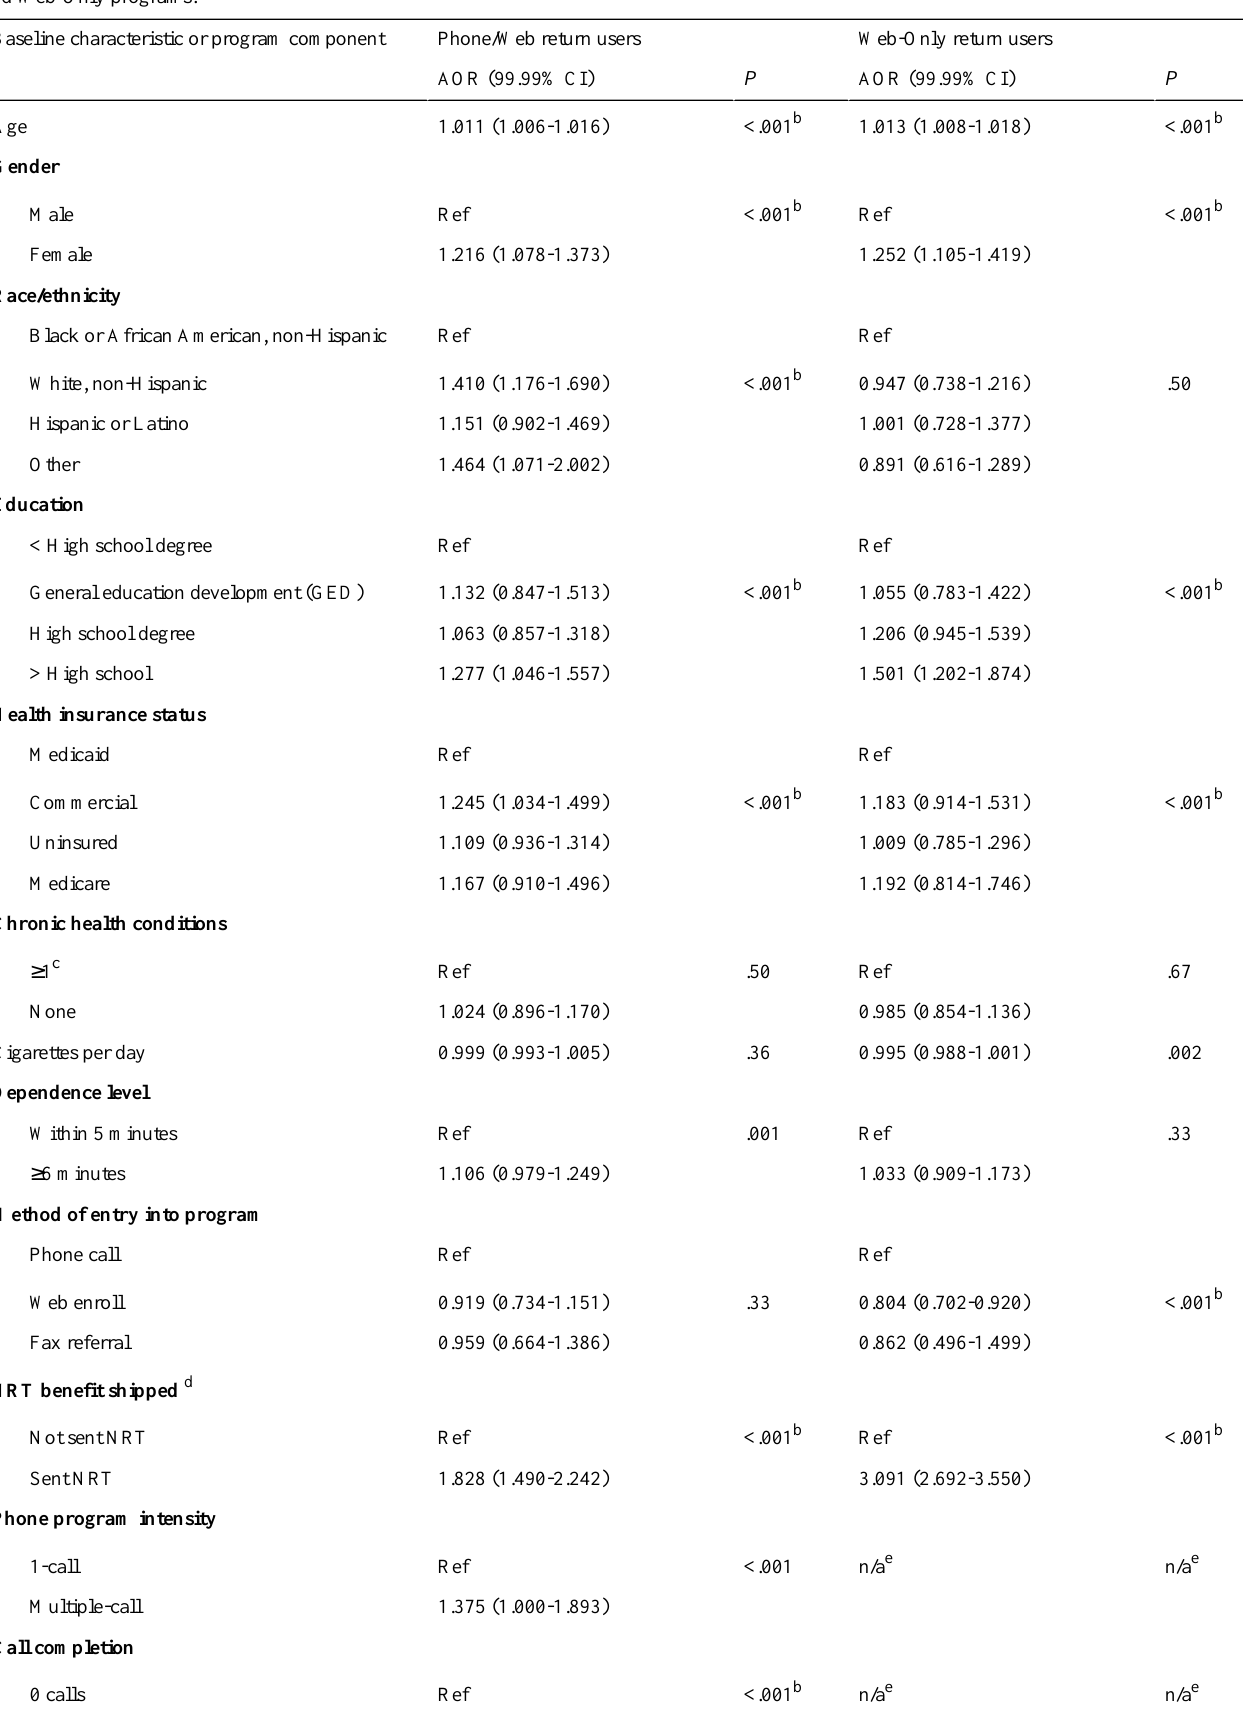
Table 5. Multivariable models of the relationship of participant characteristics and likelihood of returning to the Web Coach website within Phone/Web and Web-Only programs.